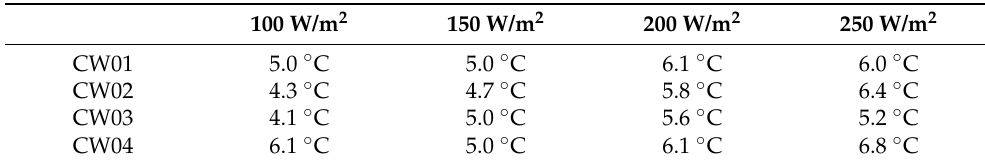
Table 9. The temperature drop during the discharging